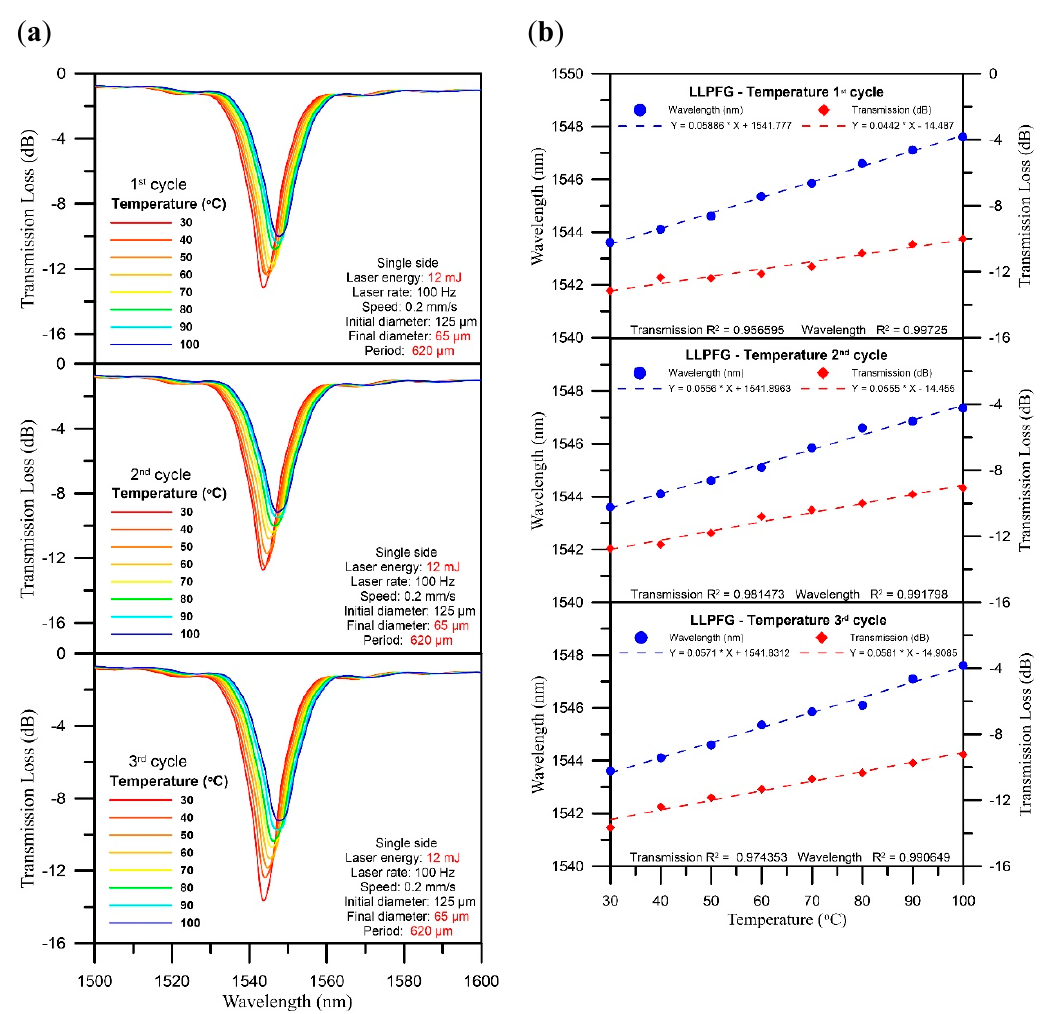
Figure 8. The LPFG sensor without PEDOT:PSS: ( a ) three-cycle temperature test spectrogram with 10 °C intervals; ( b ) chart of wavelength loss over three temperature test cycles.